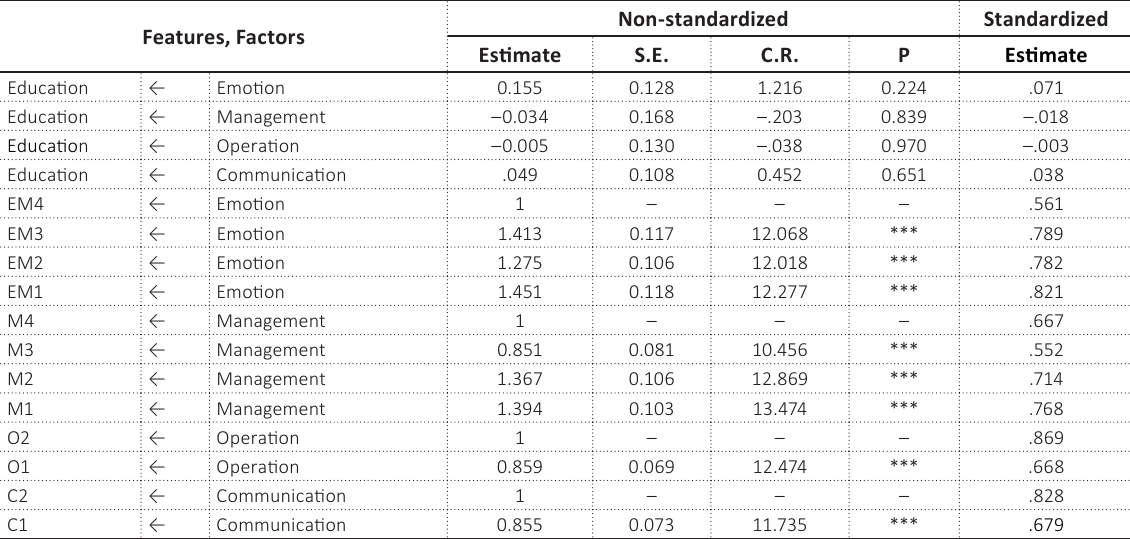
Table 7. Regression